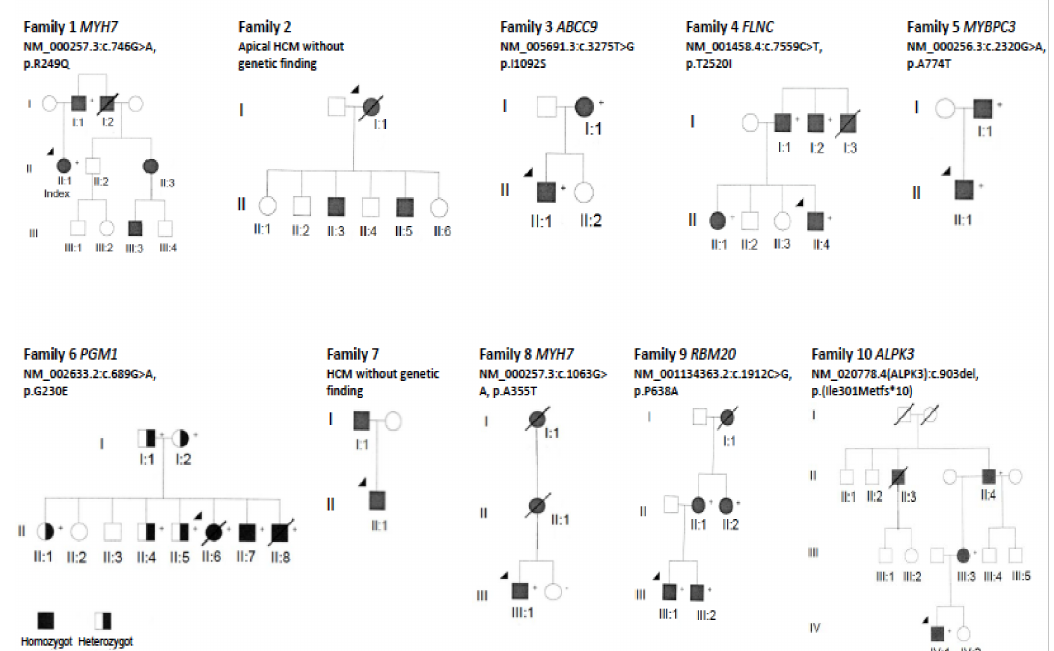
Figure 2. Pedigree of the families in this study. Circles in the pedigree denote females, squares males. A crossed-over symbol indicates that the particular individual has died. The arrow points out the index patient in each family. The autosomal dominant genetic variant detected in each family is indicated with a ‘ + ’ sign if the individual is a carrier. The black color filling indicates clinical disease presentation. Of note, in Family 6 there is the autosomal recessive disorder PGM1 -CDG, where the black color filling show homozygous patients with clinical disease, and half-filling represent heterozygous asymptomatic